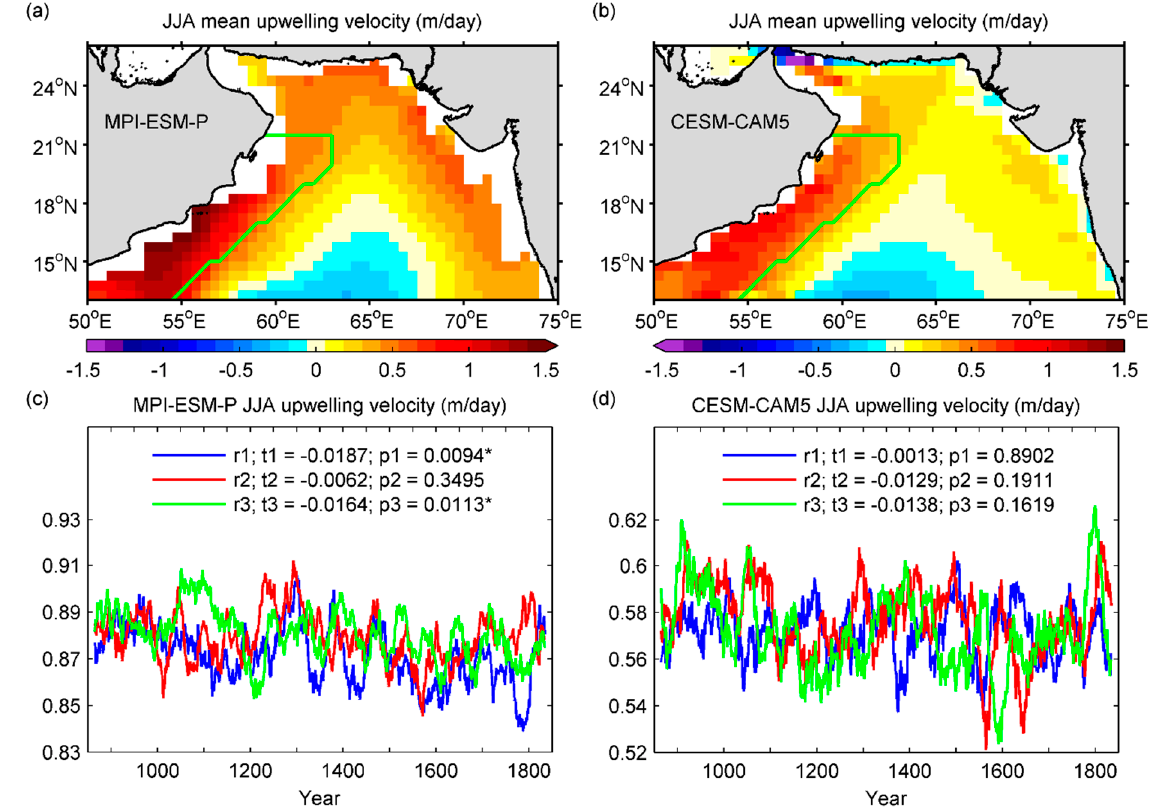
Figure 1. Spatial patterns of JJA mean Arabian Sea upwelling velocity modeled by ( a ) MPI-ESM-P and ( b ) CESM-CAM5. Time series of JJA coastal upwelling velocity in the western Arabian Sea modeled by ( c ) MPI-ESM-P and ( d ) CESM-CAM5. The area selected for calculating the variable time series is shown in ( a , b ) within the green line. The plotted time series are smoothed by a 31-year moving mean window and r1, r2, r3 represent the three simulations. t1, t2, t3 are the trends (per 1000 years) of each simulation with p1, p2 and p3 indicating their p -values, respectively, and the star symbols mark the simulations that pass the significance test at the 95% level.